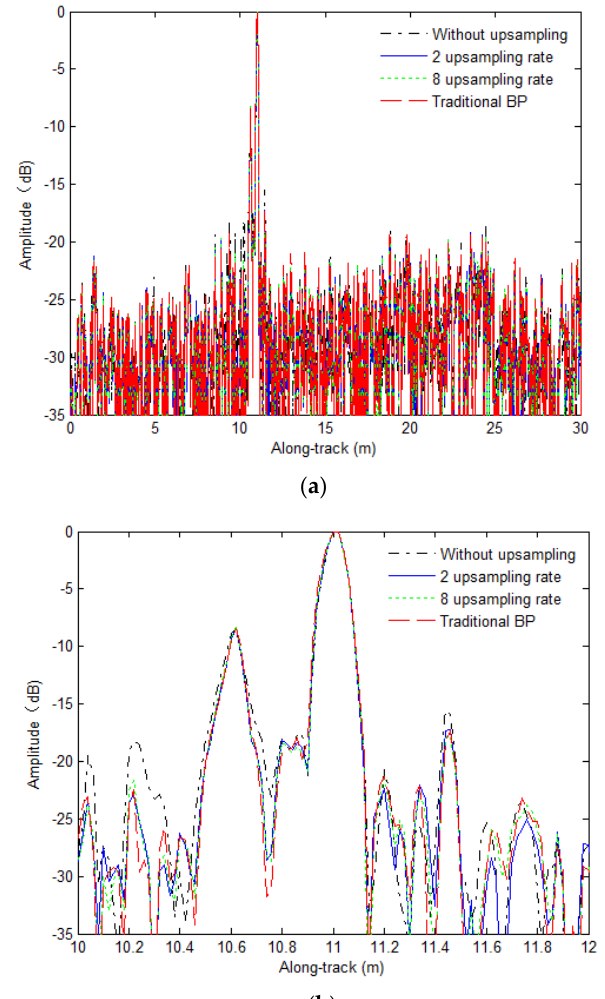
Figure 14. Along − track slices of target marked by a red circle in Figure 9. ( a ) Global slices; ( b ) close look.